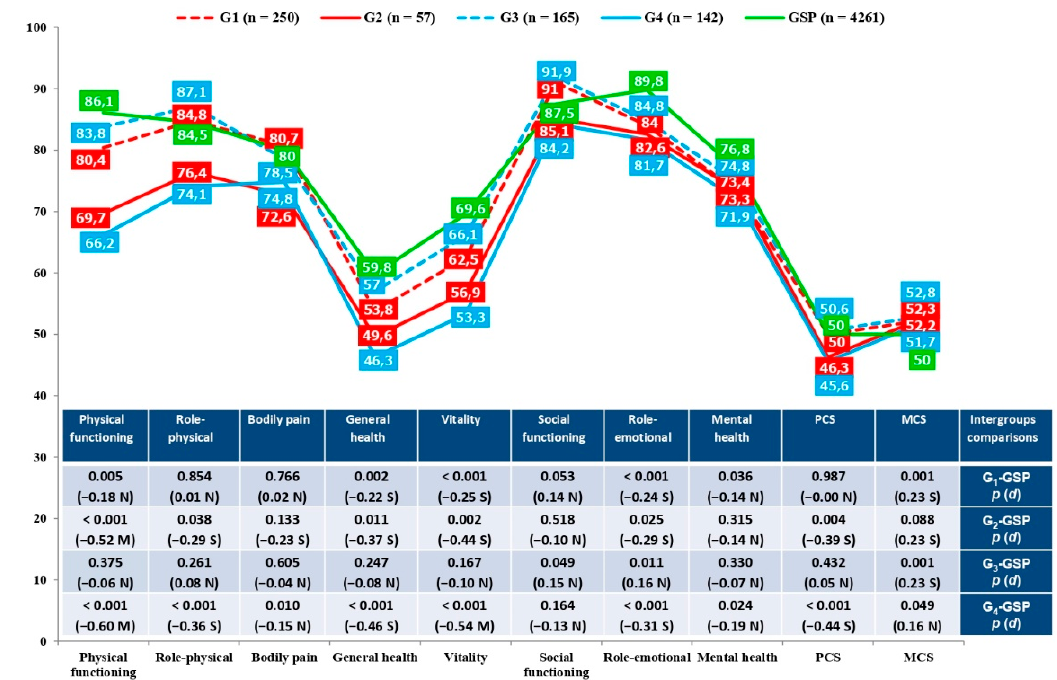
Figure 3. Comparison of quality of life (SF-12) of groups of patients and the general Spanish population. Note. G 1 : absence T2DM; G 2 : presence T2DM; G 3 : absence obesity; G 4 : presence obesity; GSP: general Spanish population; PCS: physical